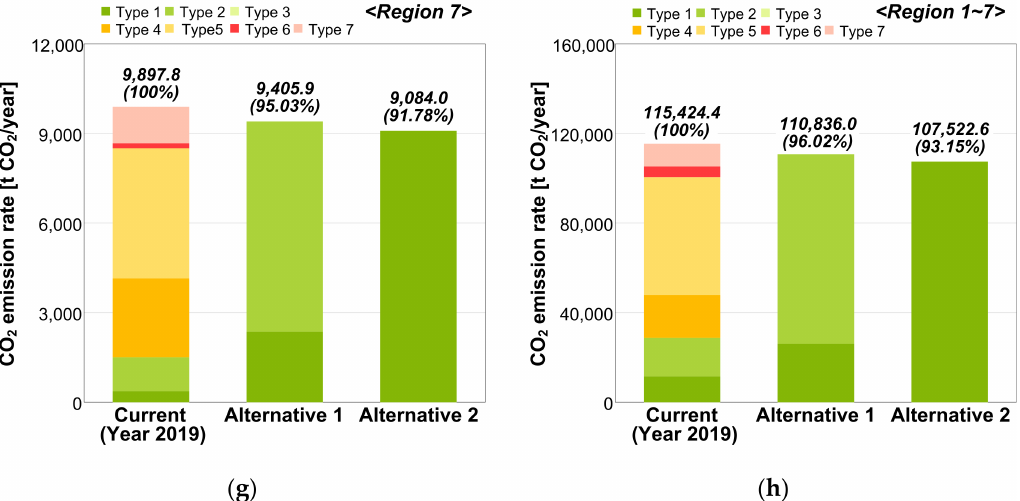
Figure 5. CO 2 emission rate by window configurations in ( a ) region 1, ( b ) region 2, ( c ) region 3, ( d ) region 4, ( e ) region 5, ( f ) region 6, ( g ) region 7, and ( h ) nationwide.